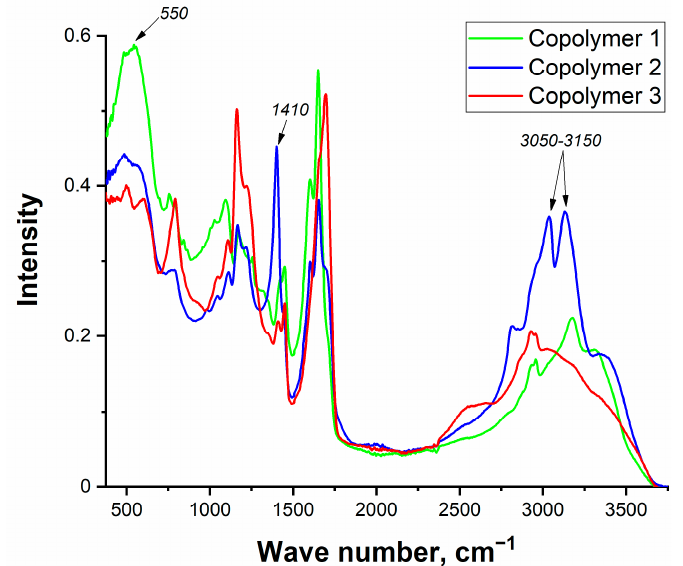
Figure 13. IR spectra of metallopolymers after HCl-accelerated healing: copolymer 1—AAm/AAc = 84.5/14.5; copolymer 2—AAm/AAc = 49.5/49.5; copolymer 3—AAm/AAc = 14.5/84.5.